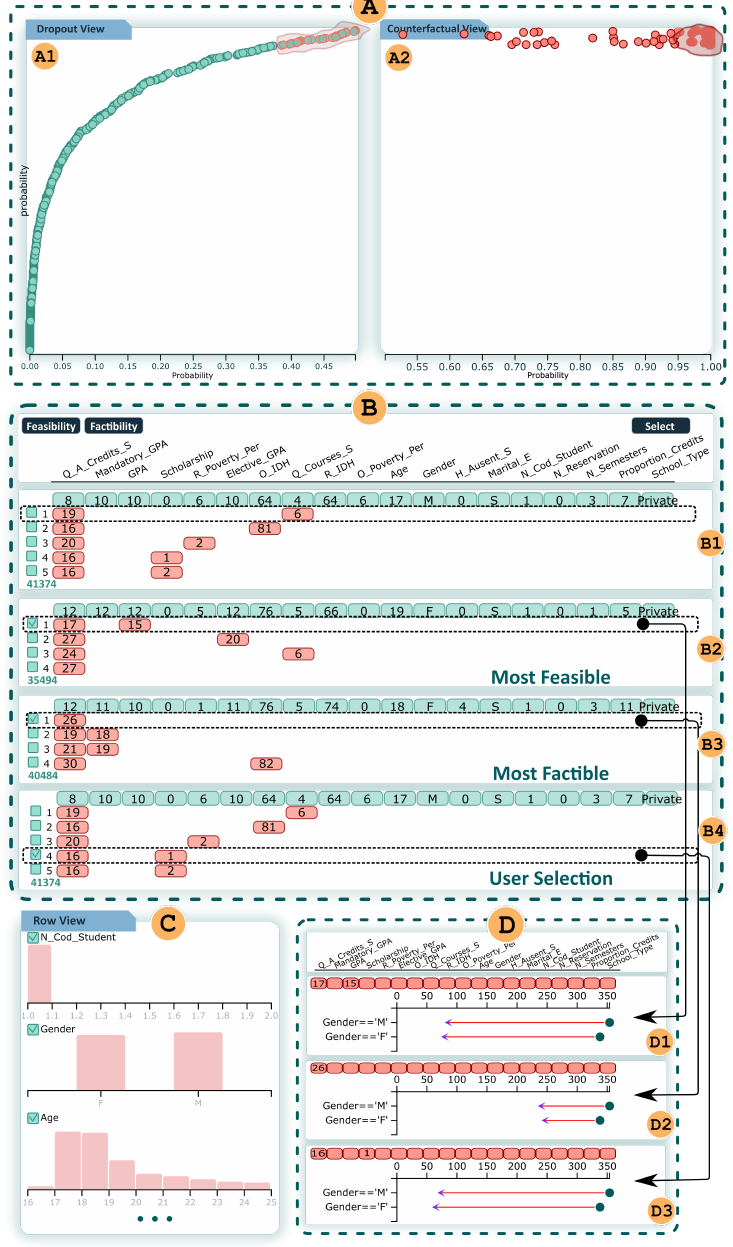
Figure 7. Analyzing counterfactual explanations for Industrial Engineering: A represents selection of students and their counterfactuals, respectively, B shows the counterfactuals, where B1 shows random counterfactuals, B2 shows the most feasible, B3 shows the most factible, and B4 shows the user-selected counterfactual. In addition, C shows the student distribution and D shows the impact of the selected counterfactuals